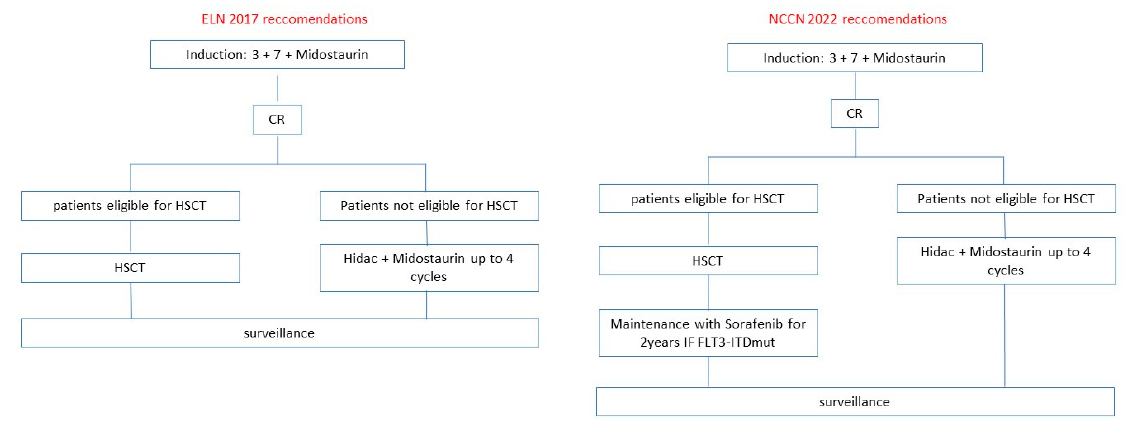
Figure 2. ELN and NCCN recommendations for FLT3mut AML patients fit for intensive treatment.